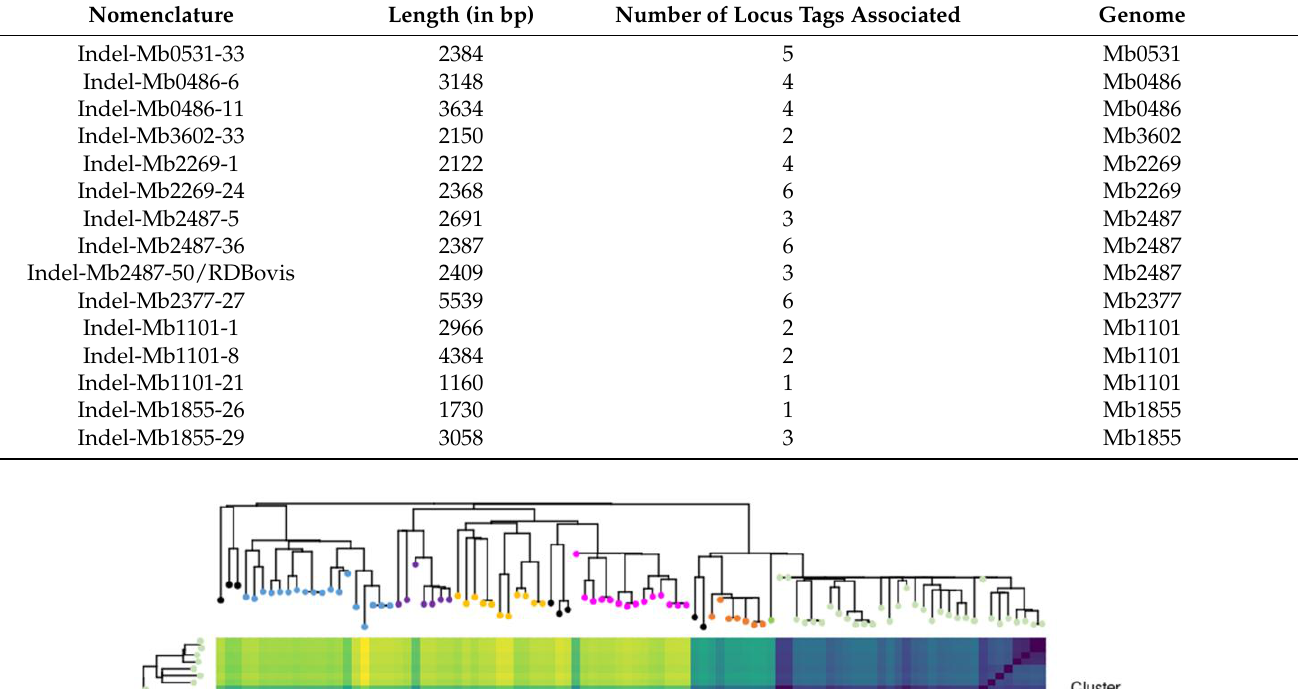
Table 2. Details of large indels affecting the genomes.